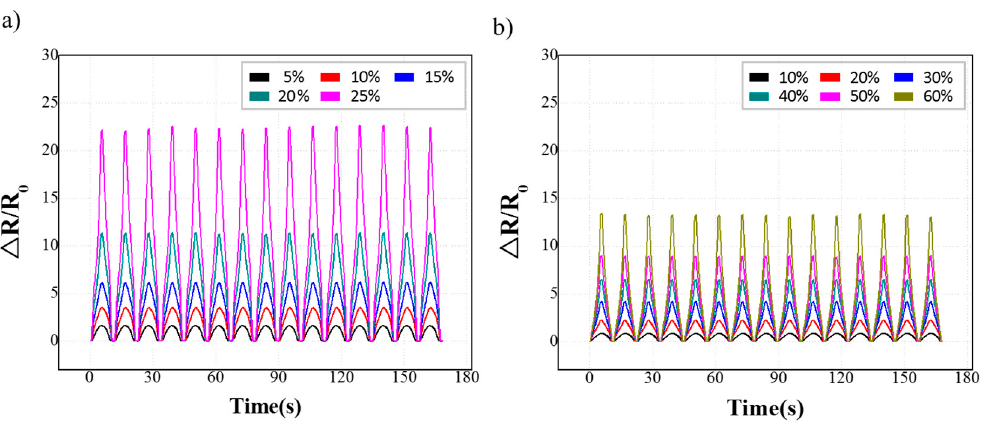
Figure 7. Loading/unloading behaviors. ( a ) Measurement of resistance change rate according to the elongation of the longitudinally aligned flexible strain sensor. ( b ) Measurement of resistance change rate according to the elongation of the laterally aligned flexible strain sensor.